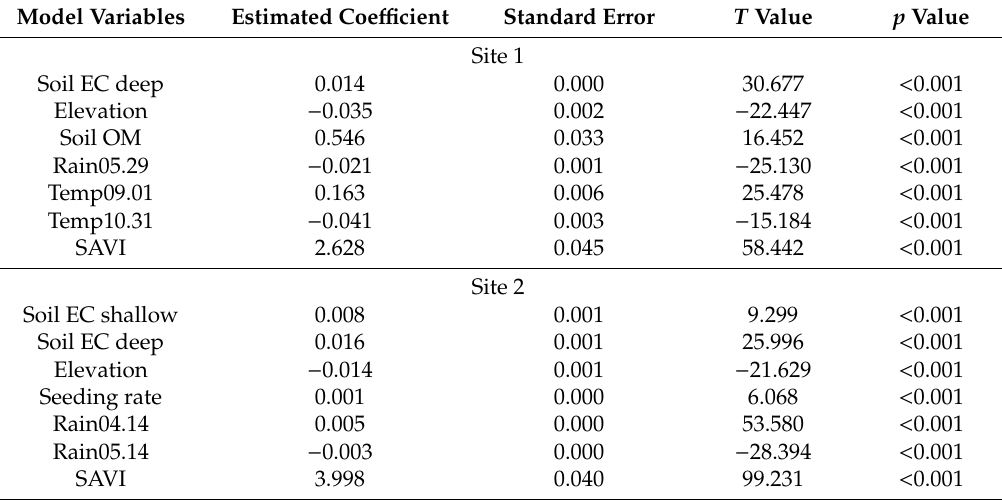
Table 5. Results of the multiple linear regression (MLR) models for the